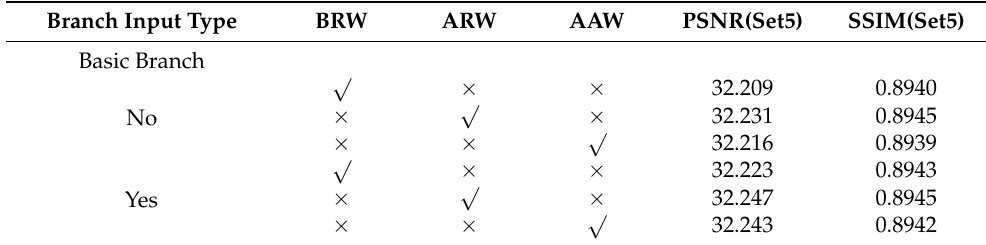
Table 1. Influence of information input location between branches in basic blocks on network